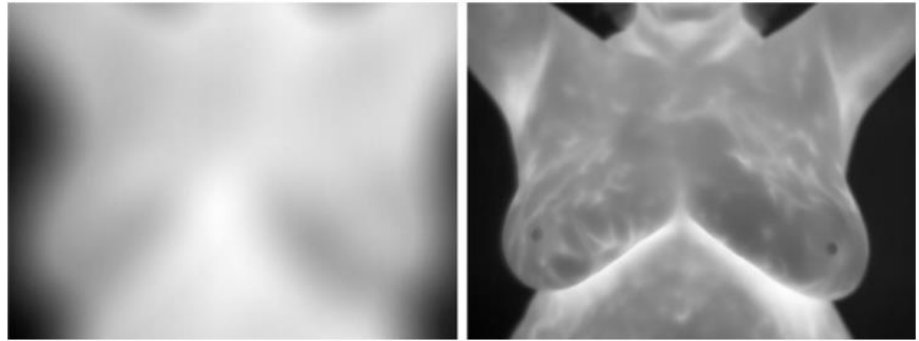
Figure 2. Depiction of fuzzy (left) and accepted (right) thermal images of the